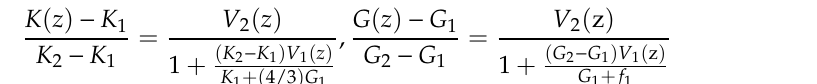
(a) (b) Figure 2. Variations of E (z) and ( ) z ρ for Al/Al 2 O 3 through the thickness: ( a ) E (z); ( b ) ( ) z ρ . Figure 2. Variations of E (z) and ρ ( z ) for Al / Al 2 O 3 through the thickness: ( a ) E (z); ( b )